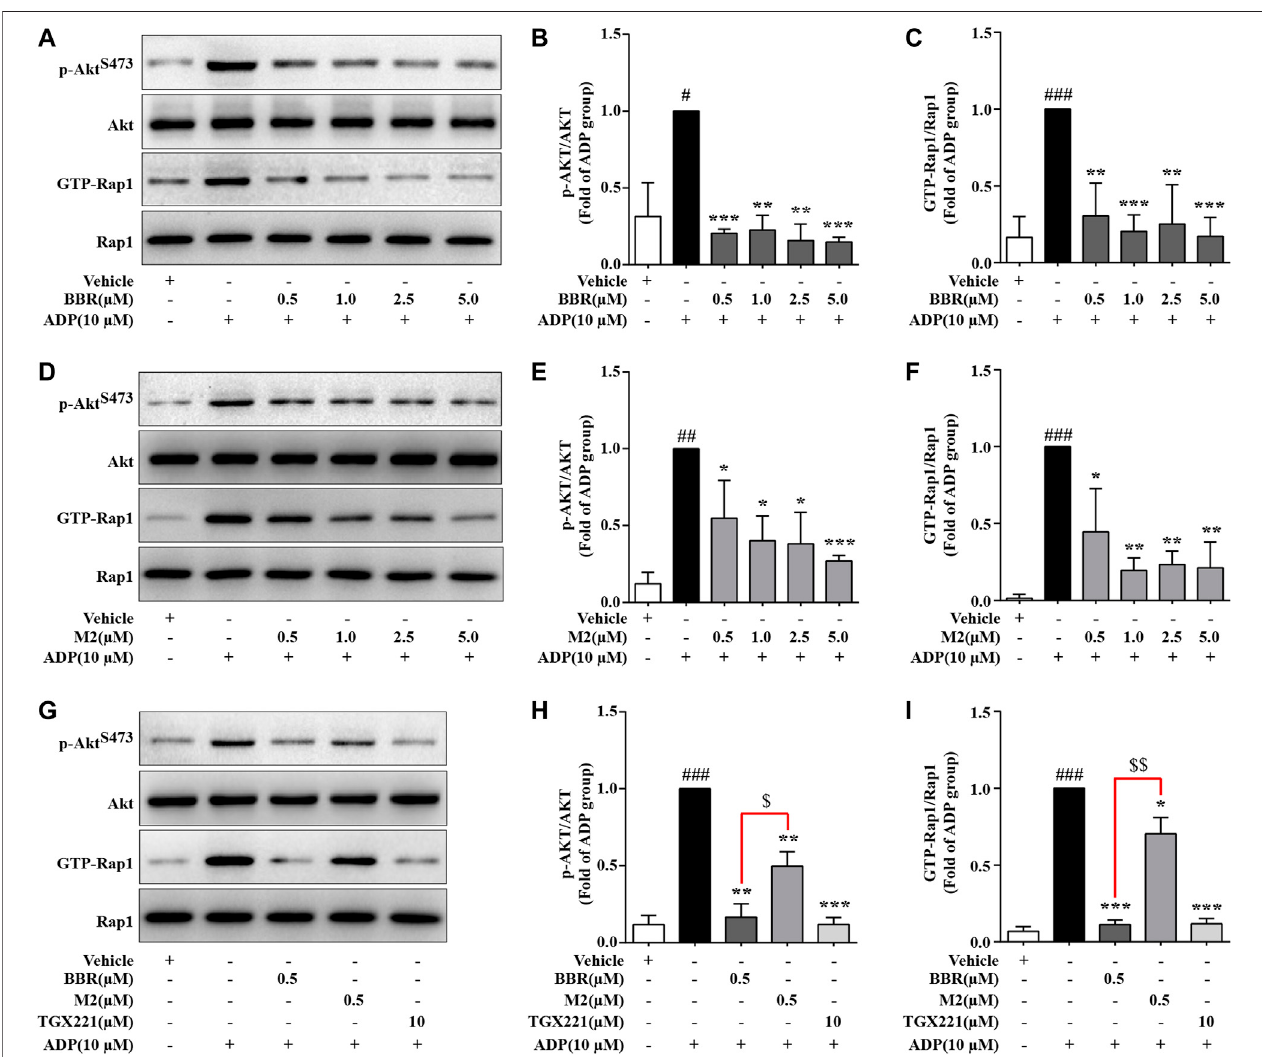
FIGURE 4 | Effects of BBR and M2 on Akt phosphorylation and Rap1 activation in ADP-stimulated platelets in vitro . The WPs were pretreated with the studied compounds or the vehicle control (0.1% DMSO) for 10 min and stimulated with 10 μ M of ADP for 10 min. After treatment, the platelets were lysed for protein extraction andWesternblotusedtodetectthelevelsofp-Akt S473 ,Akt,andRap1.Inparallelexperiments,plateletlysateswereusedto – pulldownanddetectGTP-Rap1. (A-C) The WPs were pretreated withBBR orthe vehicle control asindicated. (D-F) The WPs werepretreatedwith M2or thevehiclecontrolasindicated. (G-I) The WPs were pretreated with BBR (0.5 μ M), M2 (0.5 μ M), TGX221 (10 μ M), or the vehicle control as indicated. Representative blots are presented (A, D, G) . After quanti fi cation, the expression levels of p-Akt S473 and GTP-Rap1 were normalized to those ofAkt and Rap1, respectively,and plotted as indicated (B, C, E,F, H, I) . Dataare expressed as mean ± SD of three or four independent experiments. Statistically signi fi cant differences compared with the vehicle control group are indicated by # p < 0.05, ## p < 0.01, and ### p < 0.001. Statistically signi fi cant differences compared with the ADP group are indicated by * p < 0.05, ** p < 0.01, and *** p < 0.001, and statistically signi fi cant differences between the BBR and M2 groups are indicated by $ p < 0.05 and $$ p < 0.01.